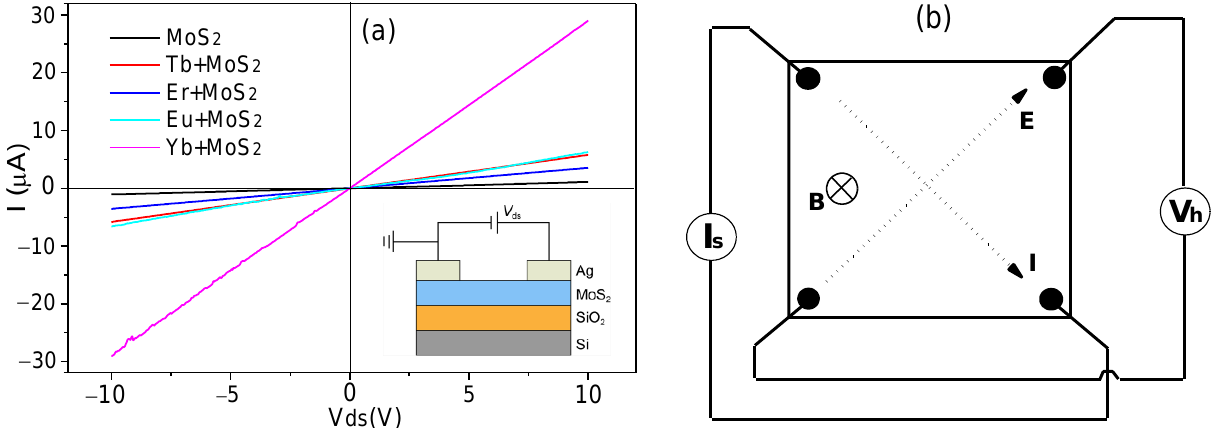
Figure 7. ( a ) The I–V curves of the samples deposited on SiO 2 /Si substrate after annealing at 550 ◦ C in Ar + 10% H 2 . The inset in Figure 7a is a schematic drawing of the sample in a circuit for I–V measurement. ( b ) A standard Hall effect setup to measure the carrier density ( n ), the electric mobility ( µ ) and the Hall coefficients (R H ) of the samples.